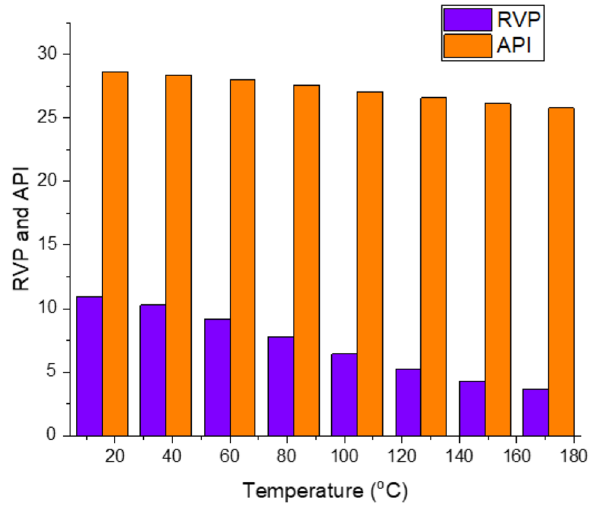
Fig. 5 Effect of temperature on RVP and API